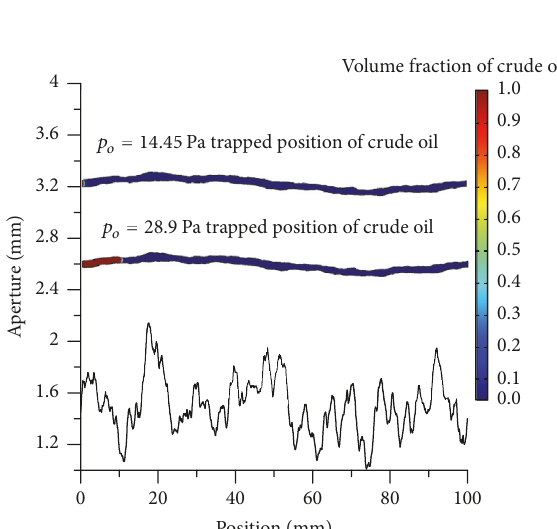
Figure 6: Distribution of aperture and trapped crude oil in the fractures.